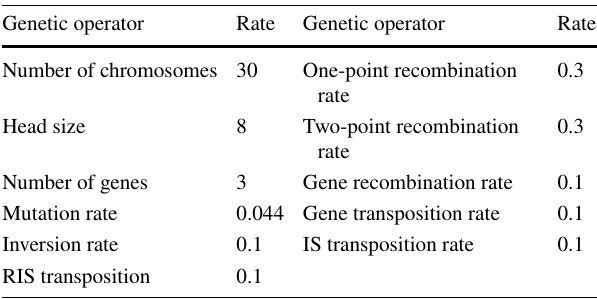
Table 1 Genetic operators and their values utilized in this study for GEP model Genetic operator Rate Genetic